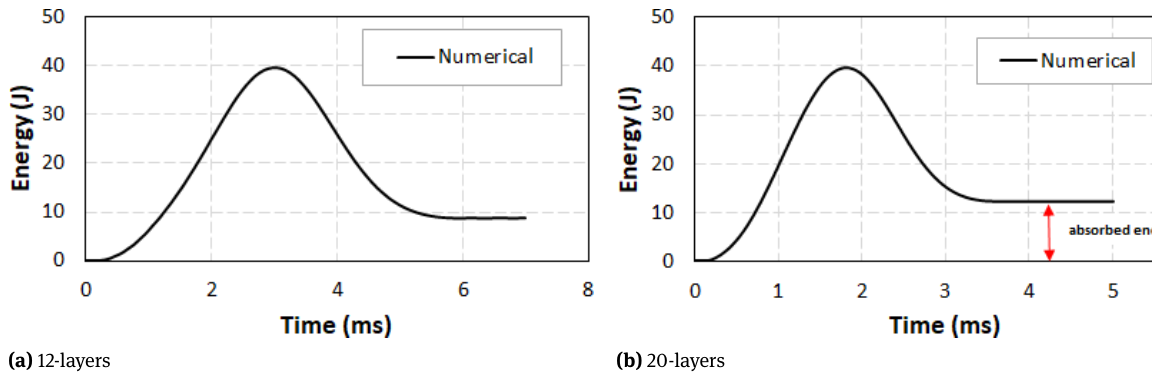
Figure 10: Numerical energy absorption of Kevlar reinforced epoxy